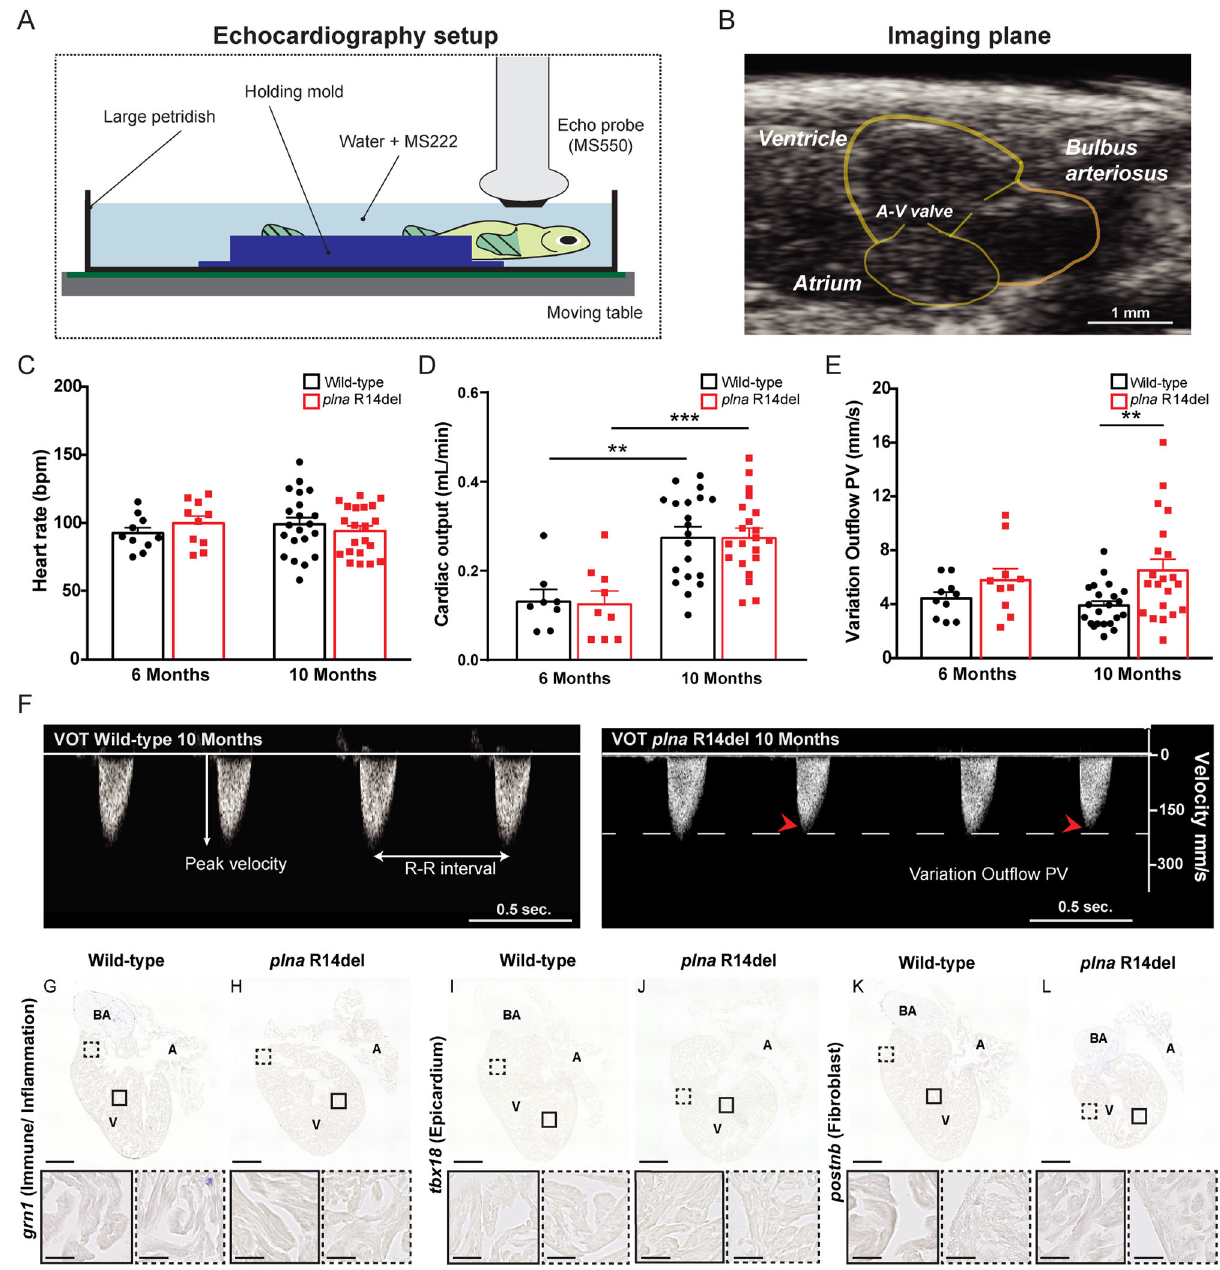
Fig. 3 Contractile variations in the structural normal adult plna R14del zebra fi sh heart. A Graphical illustration of the zebra fi sh echocardiography imaging setup. B B-mode echocardiography imaging plane of the adult zebra fi sh heart, ventricular walls, and cardiac valves are depicted in yellow. C Heart rate of wild type (WT) and plna R14del mutant zebra fi sh, 6 and 10 months of age (mean ± SEM, WT n = 10, plna R14del n = 21, two-way ANOVA). D Cardiac output of WT and plna R14del zebra fi sh, 6 and 10 months of age (mean ± SEM, ** p = 0.0013, *** p = 0.004, WT n = 10, plna R14del n = 21, one- way ANOVA). E Variation in out fl ow peak velocity in WT and plna R14del zebra fi sh, 6 and 10 months of age (mean ± SEM, ** p = 0.01954, WT n = 10, plna R14del n = 21, one-way ANOVA). F Representative examples of color Doppler ventricular out fl ow measurements in 10-month-old WT and plna R14del zebra fi sh. Dashed white and red arrows indicate maximum and minimum peak velocities, respectively. All measurements were performed in two experimental replicates. G – L Representative images of in situ hybridization of these hearts with markers to observe immune/in fl ammation, epicardium, and fi broblasts (using grn1 , tbx18 , and postnb , respectively). All stainings were performed on WT n = 3, plna R14del n = 3, two experimental replicates. Images were taken at a magni fi cation of ×20. Scale bars are 200 µ m for whole-heart tile scans and 50 µ m for zoom-in regions. Wild type are highlighted in black and plna R14del in red. A atrium, V ventricle, BA bulbus arteriosus, A – V valve atrial – ventricular valve, Vent. out fl ow ventricular out fl ow, variation out fl ow PV variation out fl ow peak velocity, bpm beats per minute, ml/min milliliter per minute, mm/s millimeter per second, VOT ventricular out fl ow tract. Source data are provided as a Source Data fi le.